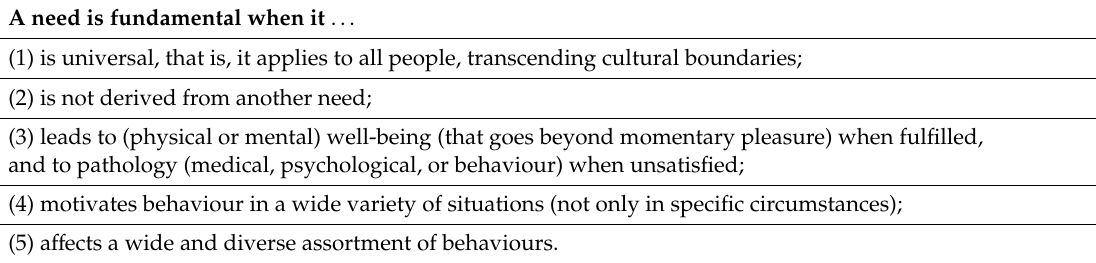
Table 2. Five criteria for fundamental psychological